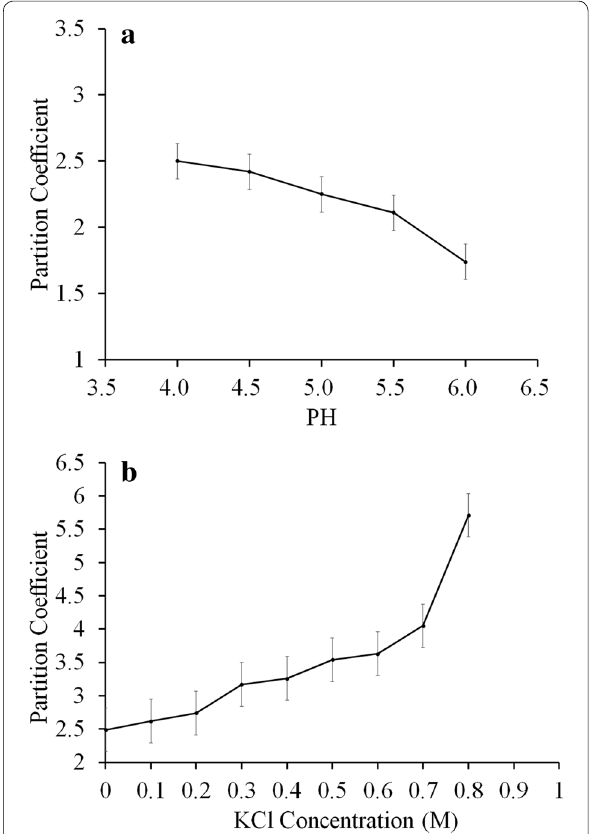
Fig. 9 Effect of pH ( a ) and KCl concentration (0.1–1.0 M) ( b ) on the partition of VB 12 . 100 mM KCl was used in a and pH 4.0 was used in